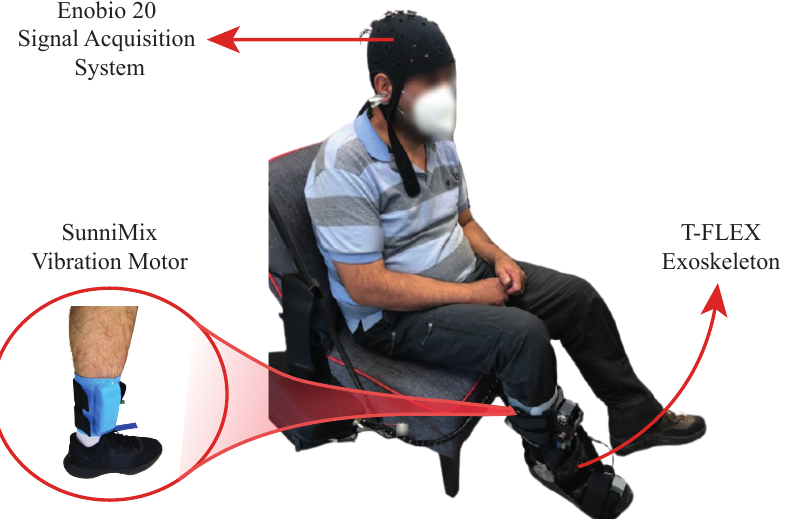
Figure 4. Experimental system setup for BCI-based control using T-FLEX with visual and haptic